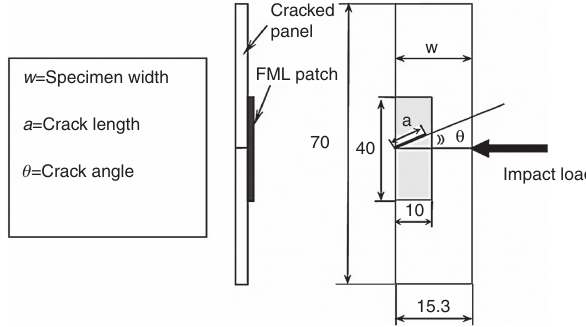
Figure 2 Geometry of patched specimen (mm).